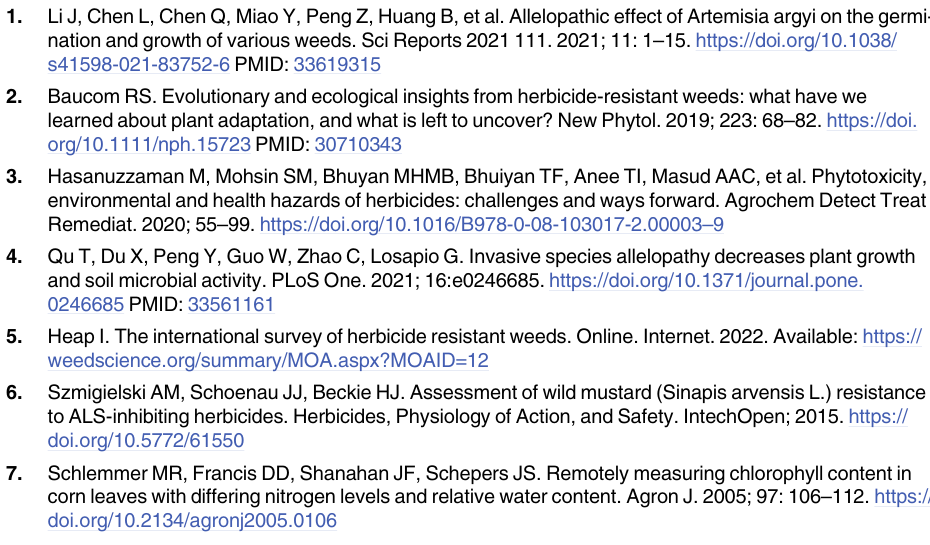
S1 Raw image. Raw gel image for psbA and tubulin expression in Sinapis arvensis , Lolium multiflorum and Parthenium hysterophorus after 48 h in response to FA and GA treat- ments. For each weed; (i) 1mM FA; (ii) 2mM FA; (iii) 3mM FA; (iv) 1mM GA; (v) 2mM GA; manuscript). Gels were visualized and photographed for analysis in gel documentation system (Genosens 1560). S1 Table. Quantification data of reference gene (tubulin) determined through Image J soft-